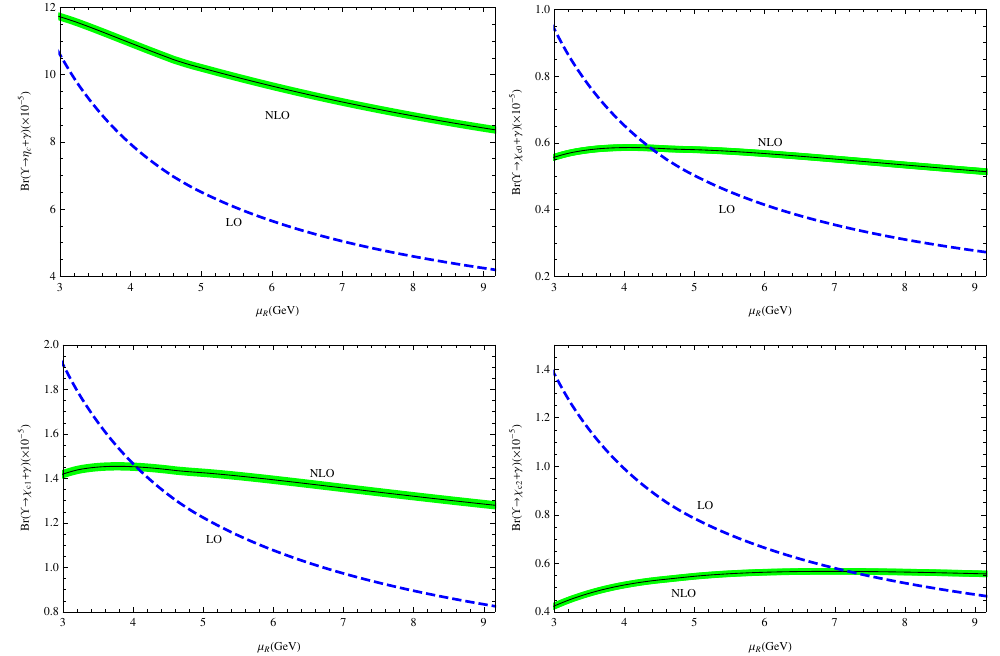
Figure 2 . NRQCD predictions for Br(Υ → H + γ ) as a function of µ R accurate up to the LO and NLO in α s . The values of the LDMEs are evaluated through the BT potential model. We take m c = 1 . 483 GeV and m b = 4 . 58 GeV. The green band represents the uncertainty band from Γ Υ and f Υ